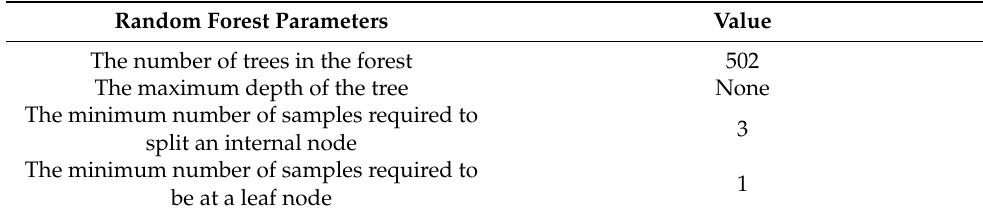
Table 2. The random forest (RF) model